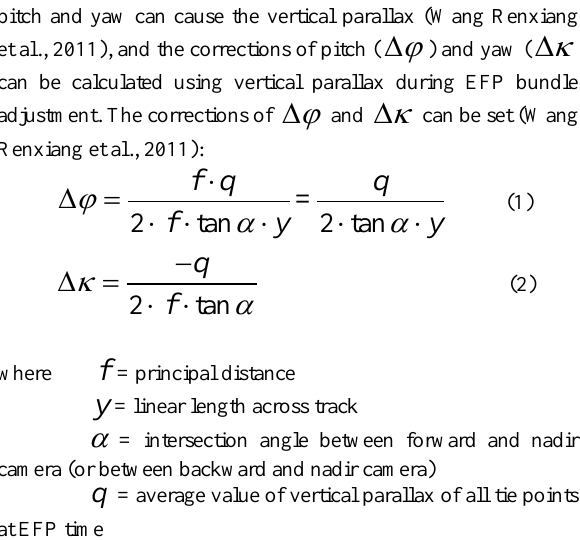
Figure 1. Stereoscopic images acquisition